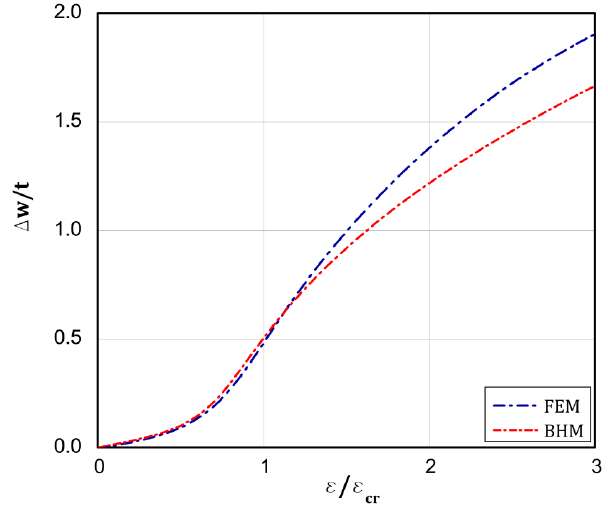
Figure 10. Dependence of ∆ w / t vs. ε / ε cr for variant A and type 5 of loads. Materials 2020 , 13 , x FOR PEER REVIEW 11 of 13